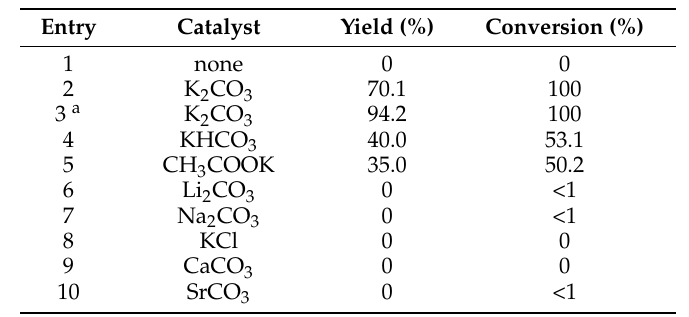
Table 2. The results for reduction of HMF to BHMF over difference